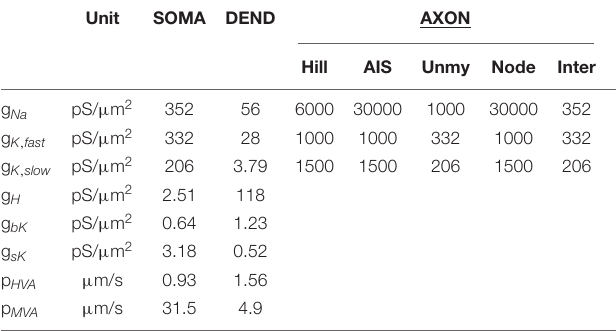
TABLE 1 | Ionic current densities along the neural membrane for PC models based on data from Mainen and Sejnowski (1996) and Almog and Korngreen